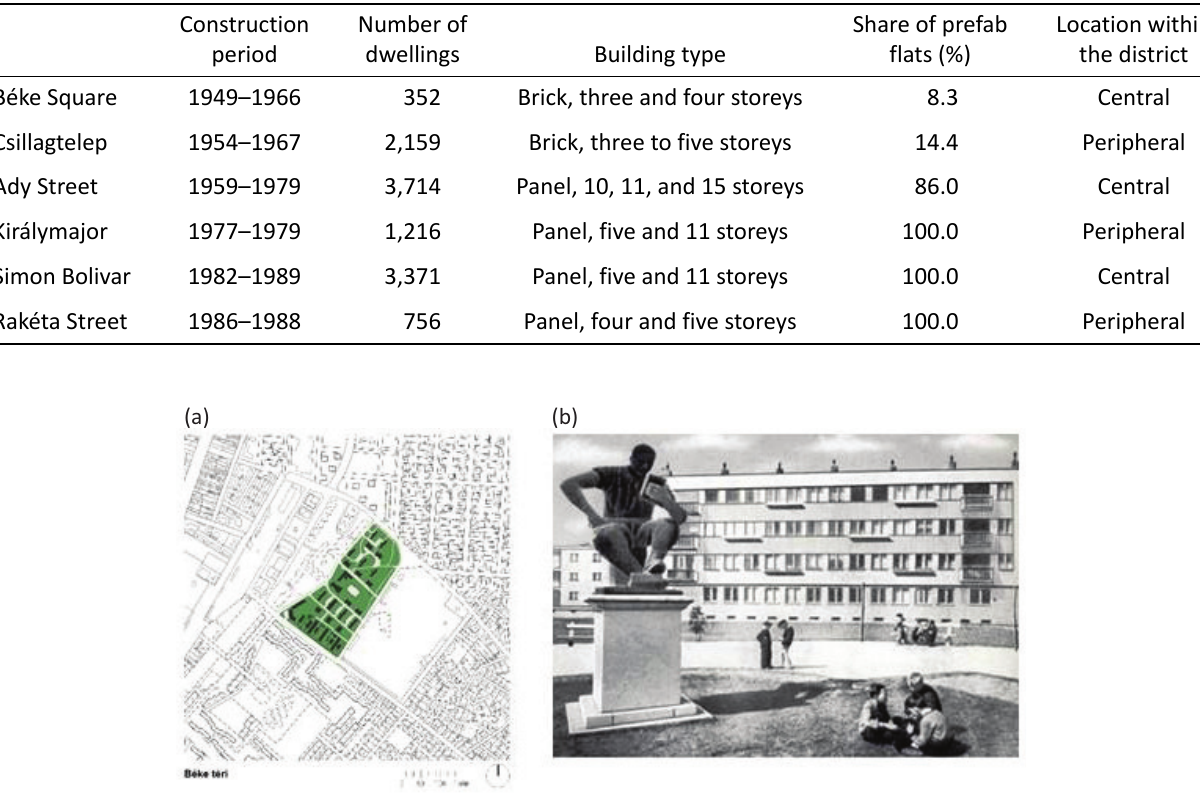
Figure 2. Béke Square HE: (a) Layout and (b) experimental type of a modern residential building with the Reading Worker statue (1951) in the foreground. Source: Sziklai